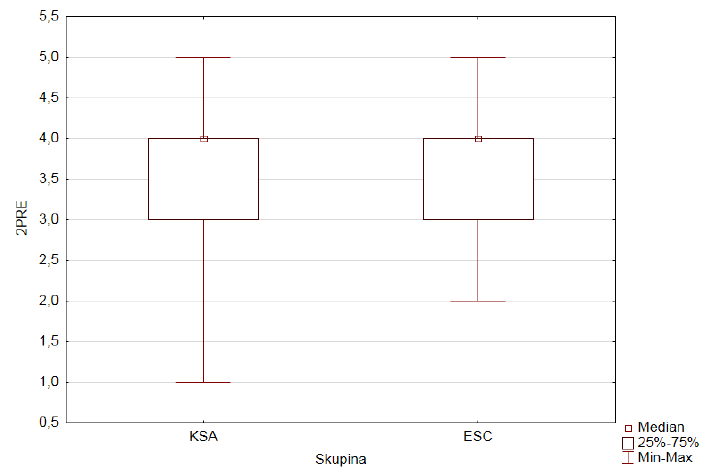
Figure 6. The box graph of the fifth item of the posttest - 5POST.